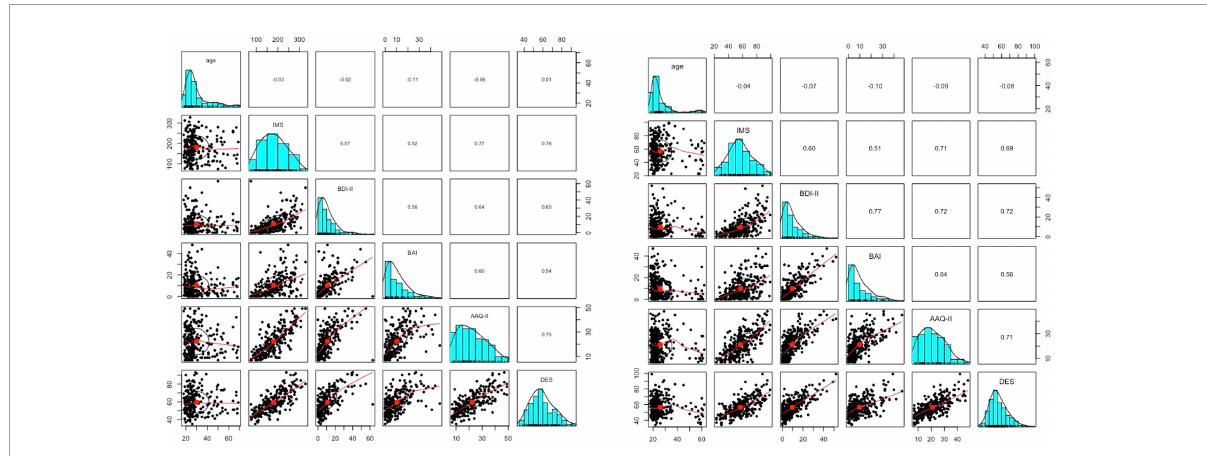
FIGURE2 Paired panels indicating the distributions by histograms, the linearity by the scatter plots and bivariate Pearson’s correlations between the different sum scores of the questionnaires and the immunization scale (IMS) for study 1 (left) and study 2 (right) .